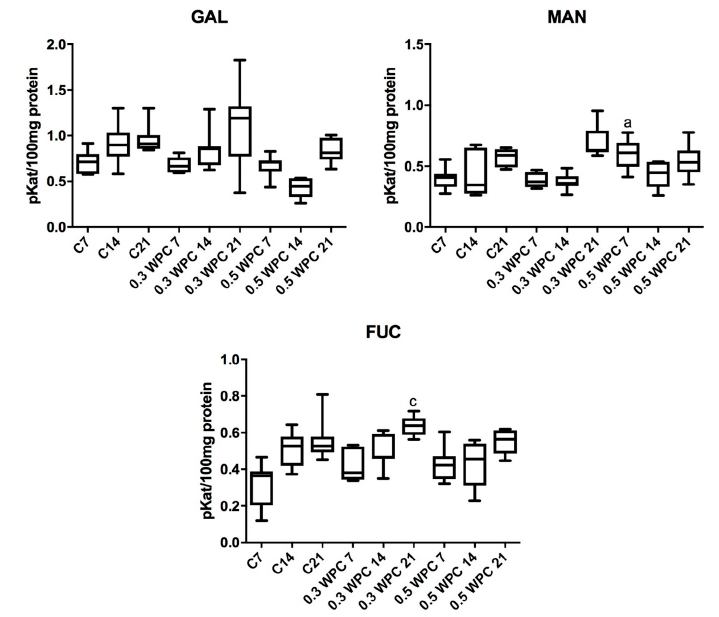
Figure 4. Activity of β -galactosidase (GAL), α -mannosidase (MAN) and α -fucosidase (FUC) in the liver of WPC-80-supplemented rats and the control group. C7, C14, C21, control groups; 0.3 WPC 7, 0.3 WPC 14, 0.3 WPC 21, 0.5 WPC 7, 0.5 WPC 14, 0.5 WPC 21, experimental groups. Differences statistically important: a vs C7; c vs C21 ( p <